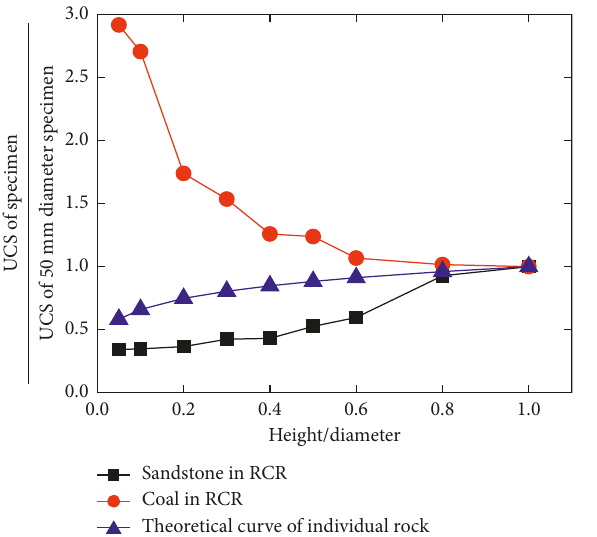
Figure 8: The USC, elastic modulus, and postpeak modulus in a typical stress-strain curve [41,